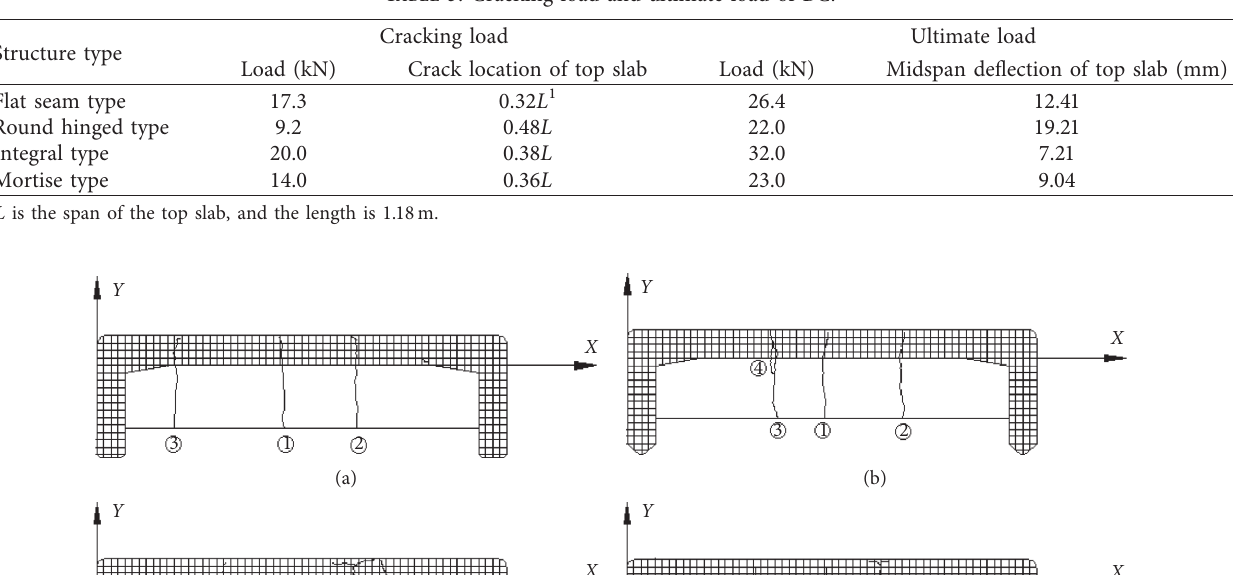
Table 3: Cracking load and ultimate load of BC.